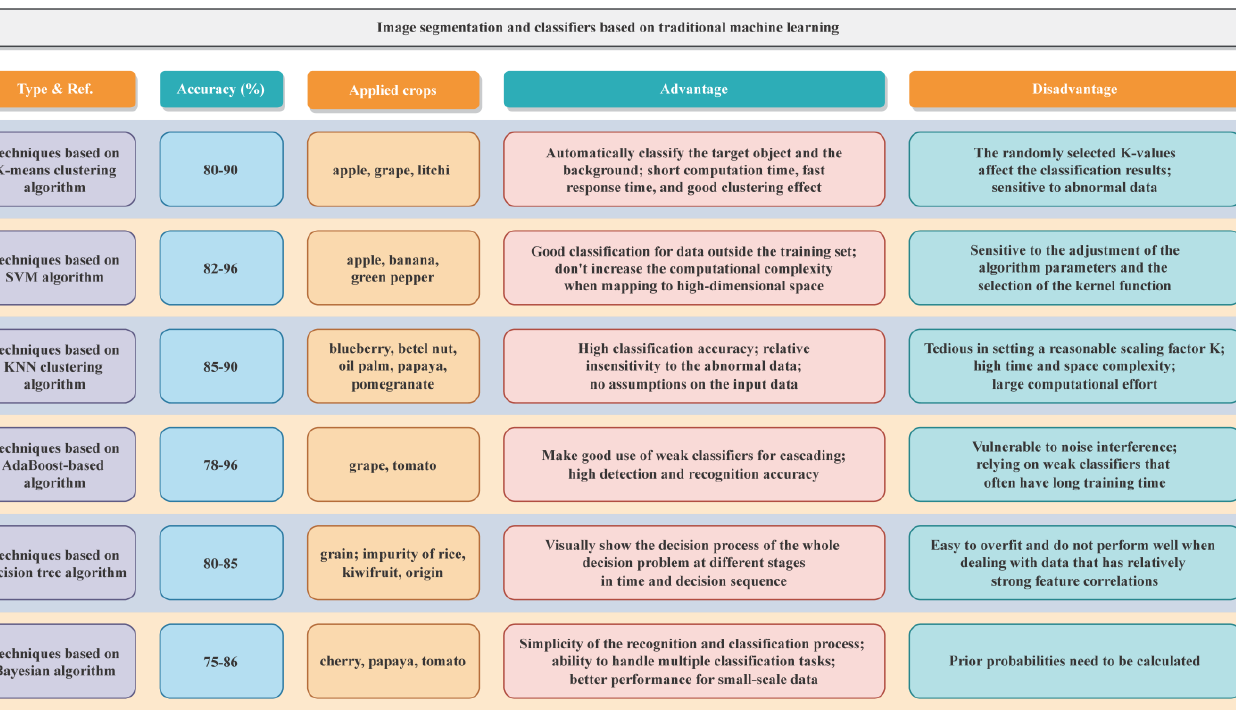
Figure 10. Techniques based on traditional machine learning